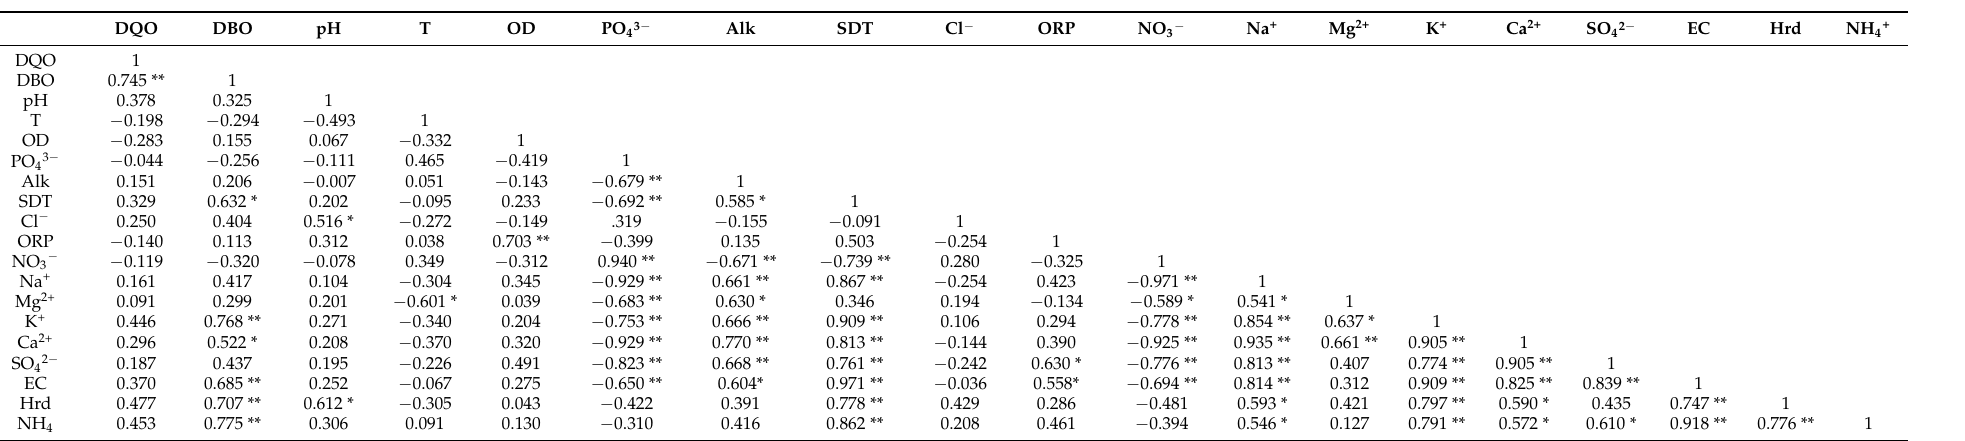
Table 2. Correlation coefficient matrix of groundwater samples of Texcalyacac